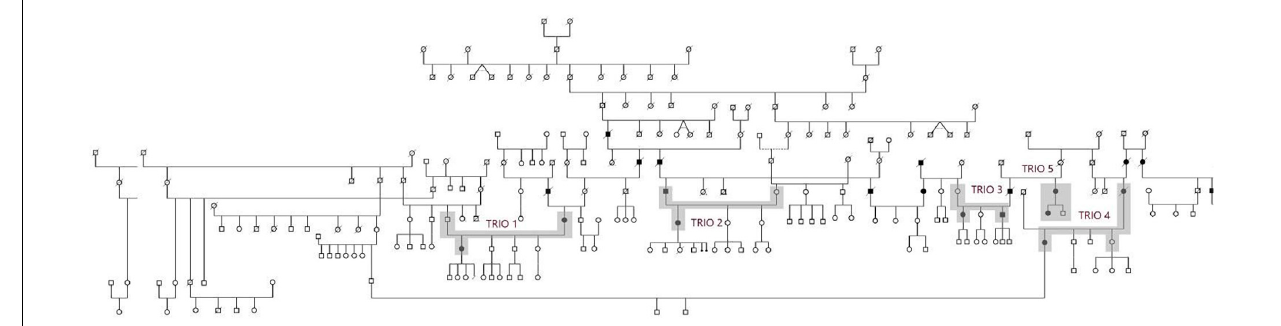
FIGURE 1 | Pedigree of family from Hornacko. Clear circle/square sign living unaffected female/male; black circle/square sign living affected female/male; symbol with a diagonal line is for deceased individual. Highlighted individuals were accessible for WES.